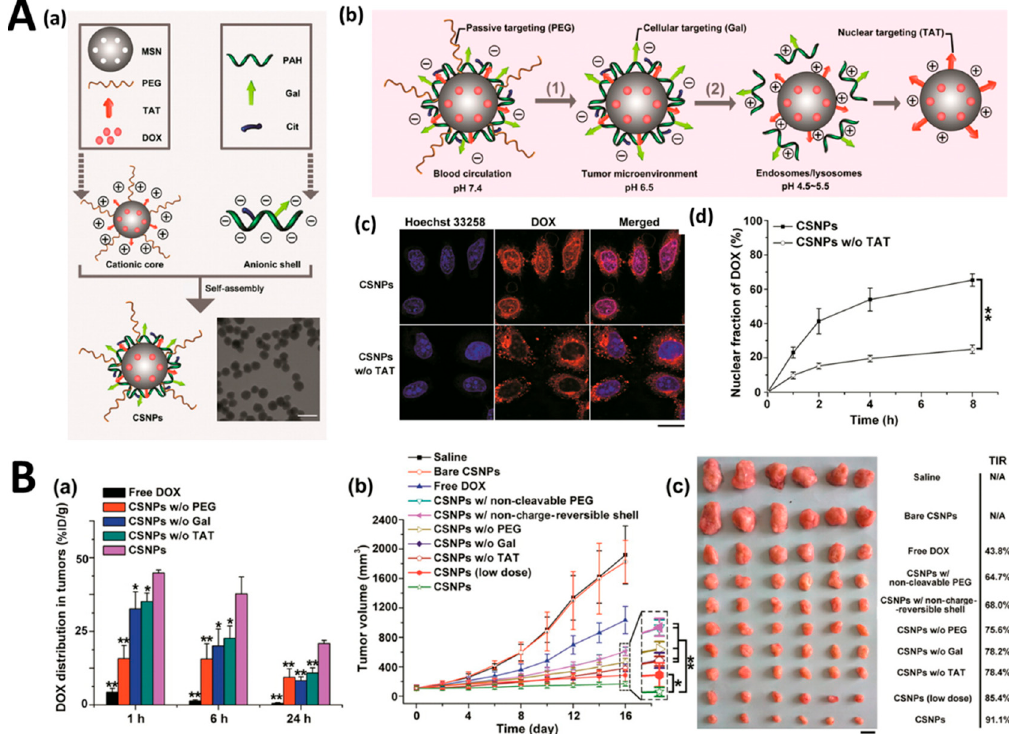
Figure 4. A core-shell silica NPs (CSNPs) for nuclear-targeted delivery of DOX to cancer cells. ( A ) Schematic illustrations showing the construction of CSNPs and their triple-stage targeting capability. ( a ) CSNPs were constructed via the electrostatic adsorption of negatively charged poly(allylamine hydrochloride)-citraconic anhydride (Gal-PAH-Cit) onto positively charged PEG-MSN-TAT. Scale bar in TEM image represents 100 nm. ( b ) Illustration of the triple-stage targeted delivery process, including the PEG-mediated passive targeting in the circulating blood (pH 7.4), Gal-mediated cellular targeting following PEG cleavage in tumor microenvironment (pH 6.5), and TAT peptide-mediated nuclear targeting after charge reversal in endosomes/lysosomes (pH 5.0). ( c ) Nuclear transport of CSNPs in QGY-7703 cells. Fluorescence images revealing the internalization of CSNPs (red, emanating from DOX) and controls CSNPs (without TAT modification) into the Hoechst 33258-labeled nuclei (blue) at 8 h postincubation. Pink fluorescence represented the overlapped signal of red and blue fluorescence. Bar refers to 20 μ m. ( d ) The distributing percentage of internalized CSNPs in the nuclei following incubation at pH 6.5 for different times ( n = 3). ** p < 0.01. ( B ) In vivo tumorous distribution and therapeutic effect of CSNPs and control preparations to H-22 tumor-bearing mice. ( a ) In vivo distribution of DOX in tumors at 1, 6, and 24 h postadministration ( n = 3). * p < 0.05, ** p < 0.01 vs CSNPs. ( b ) The changes in tumor volume ( n = 6). * p < 0.05, ** p < 0.01. ( c ) The photograph and tumor inhibition ratio (TIR) values of tumors excised from sacrificed mice. Figure reproduced from Ref. [133] with permission from American Chemical Society, 2016.